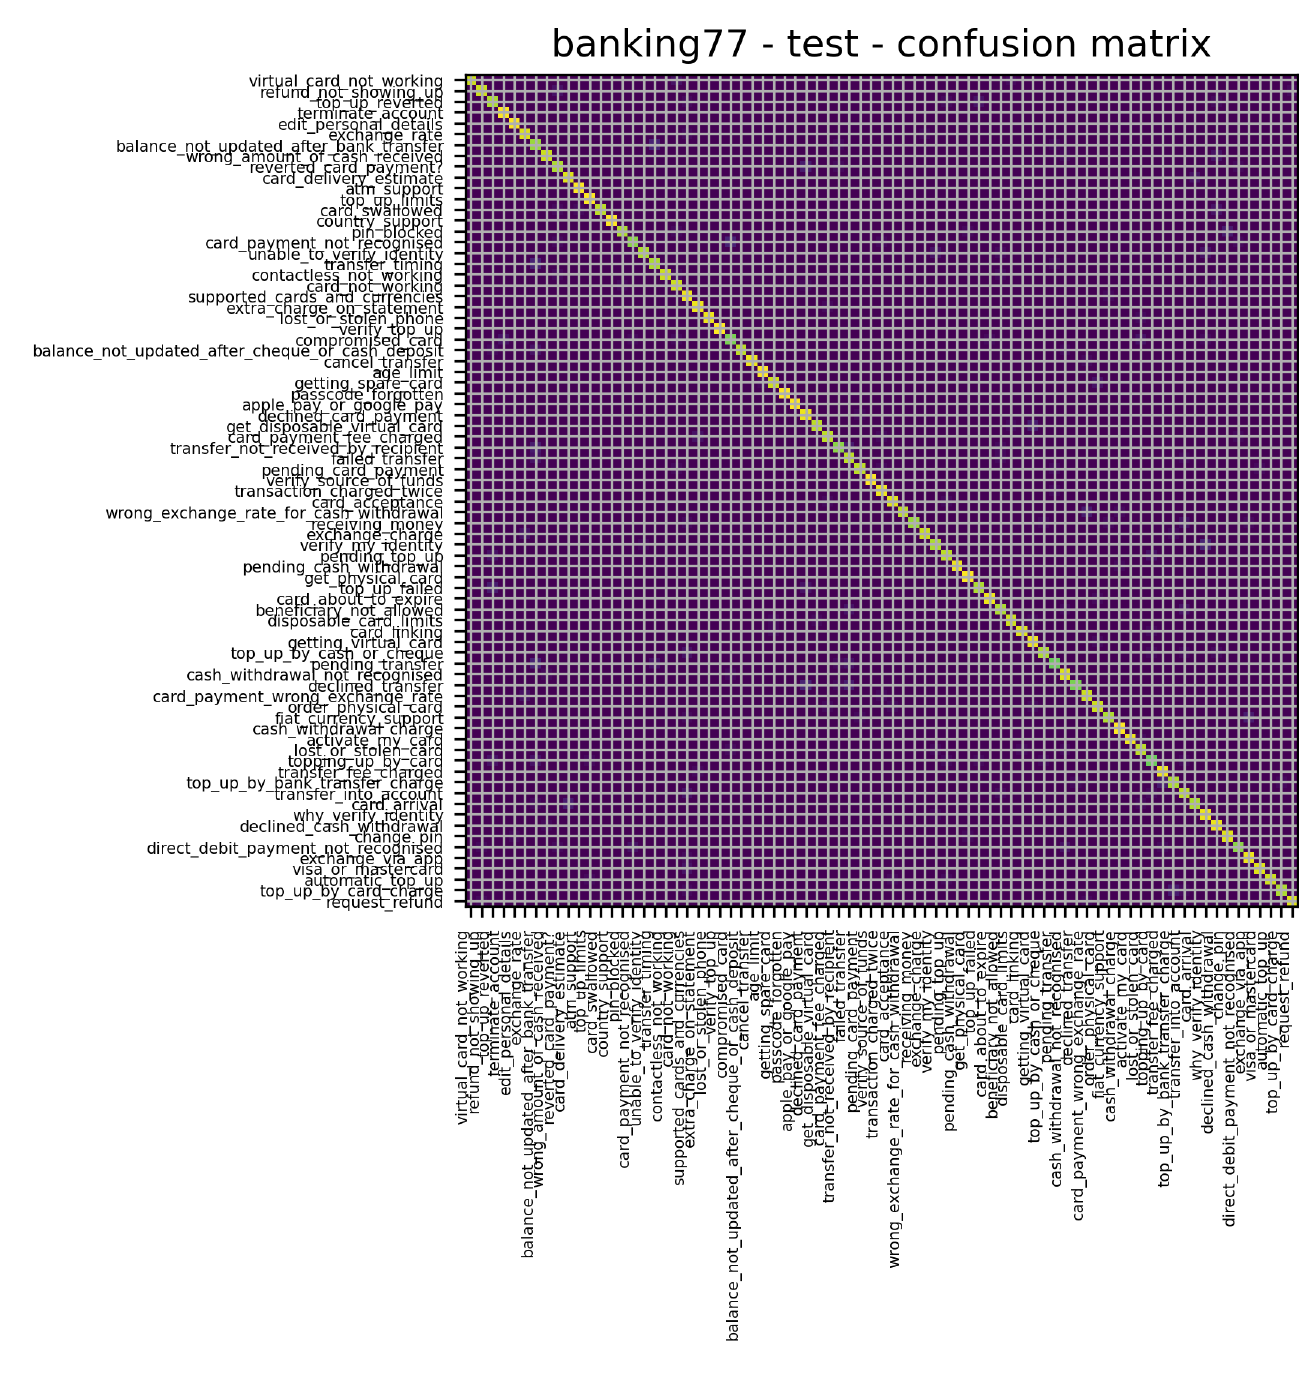
Figure A2. Full confusion matrix obtained for classifying BANKING77 test instances, with a model using the ConveRT language model featurizer. The yellow-green hue represents correctly classified test instances and it represents the main diagonal of the full